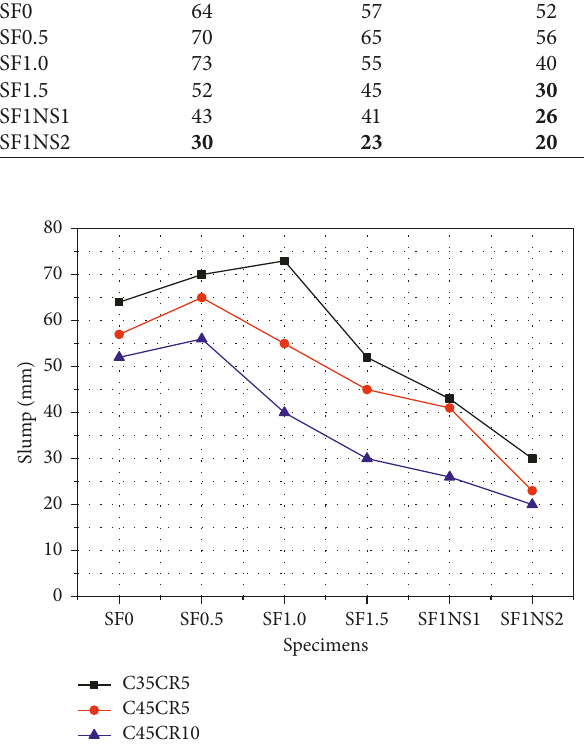
Figure 5: The slumps of concrete